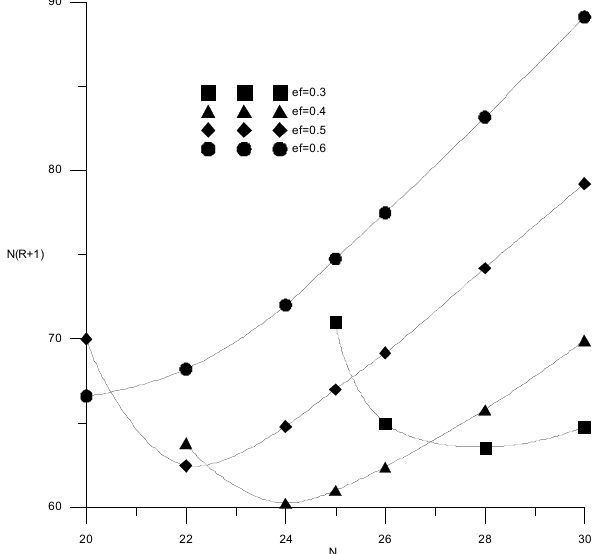
Figure 16. Capital costs for extractive rectification of the trays number in the column at different flow rates of the extractant with a water content of 3 wt %.